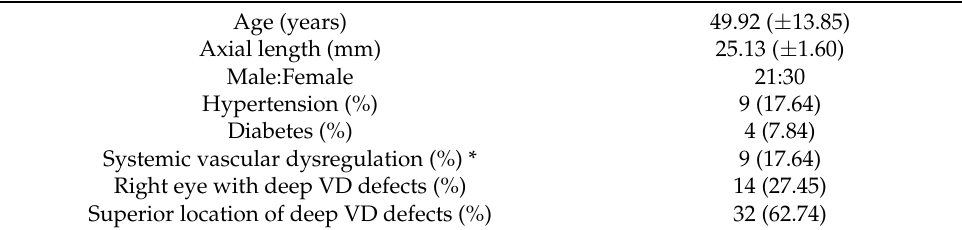
Table 1. Comparisons of baseline characteristics of study subjects ( n = 51).